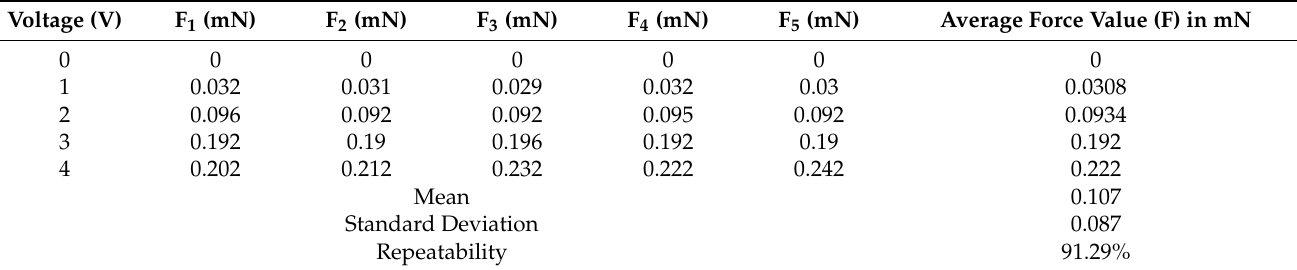
Table 2. Force data of the SPVC–PTA–Pt polymer soft actuator.